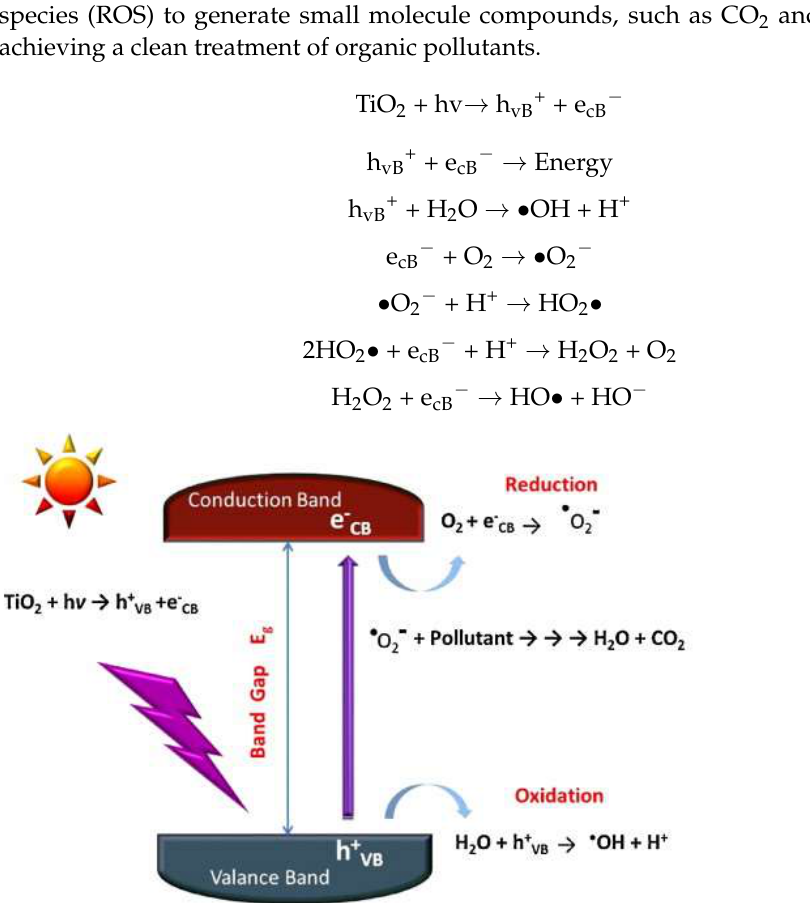
Table 2. The degradation efficiency of different modified catalysts for xanthate.